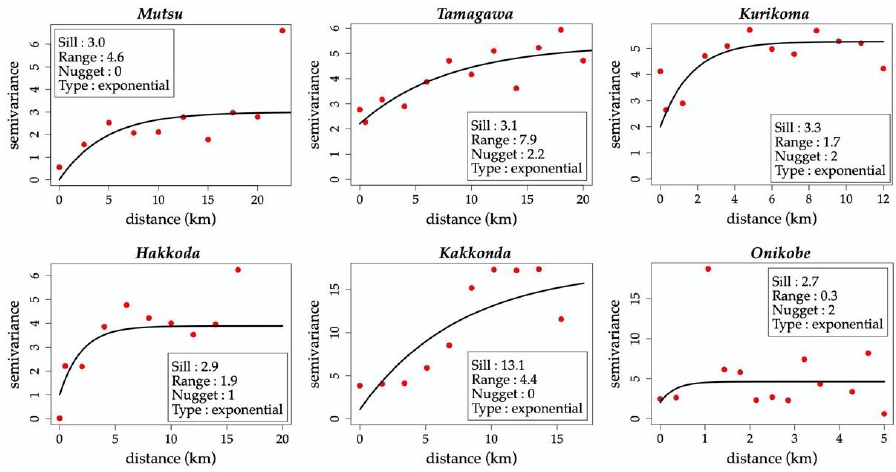
Figure 3. Semivariograms of six geothermal fields. Energies 2020 , 13 , x FOR PEER REVIEW